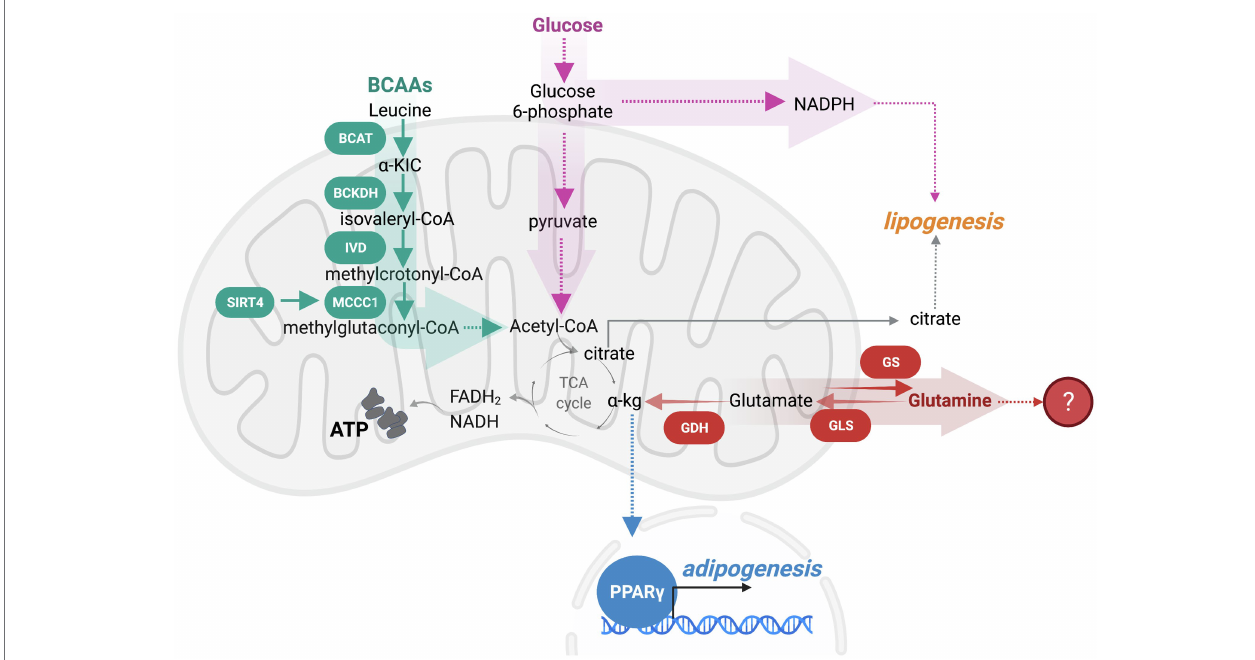
FIGURE 1 | Nutrient oxidation in the mitochondria modulates adipogenesis. Branched-chain amino acids (BCAAs) and glucose catabolism within the mitochondria produce ATP and metabolic intermediates that promote adipogenesis. As such, leucine catabolism is an early regulator of adipogenesis that is initiated by a BCAA transaminase (BCAT) generating α -ketoisocaproic acid (a-KIC). a-KIC is irreversibly oxidized by the BCAA dehydrogenase (BCKDH) complex forming isovaleryl-CoA. Isovaleryl-CoA dehydrogenase (IVD) converts isovaleryl-CoA to methylcrotonyl-CoA. Sirtuin SIRT4 induction of methylcrotonyl-CoA carboxylase (MCCC1)